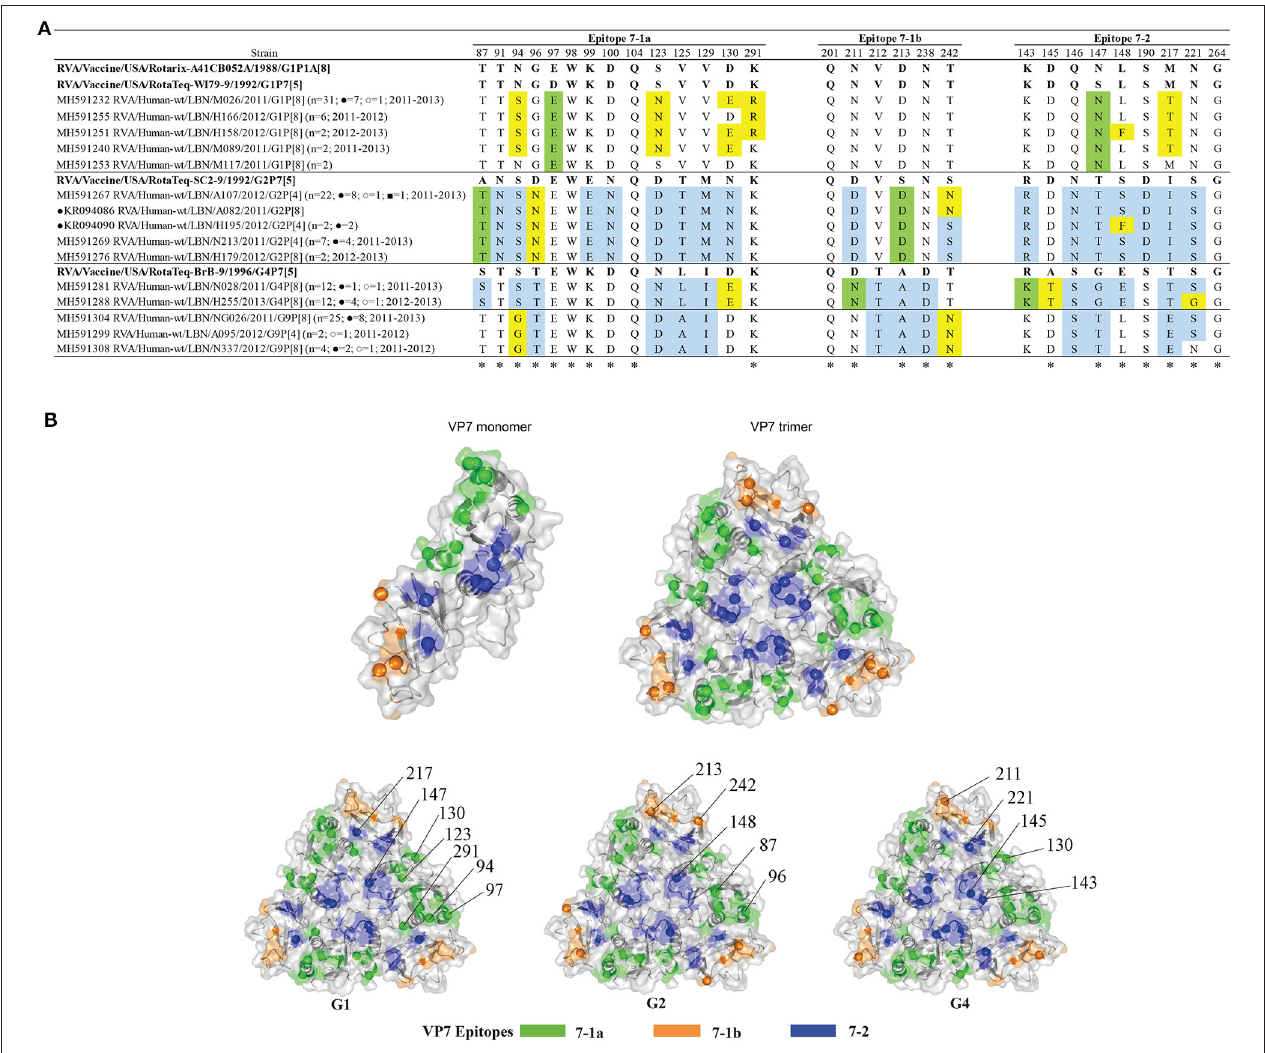
FIGURE 3 | (A) Alignment of the antigenic epitopes of VP7 of the Lebanese RVAs with those of the vaccines. Representative Lebanese strains corresponding to those in the VP7 tree are shown. Residues that are different from Rotarix ® and RotaTeq ® are highlighted in yellow, in green-color are residues that are different from the respective genotypic strain in RotaTeq ® , and in blue-color are residues that are different from Rotarix ® . Amino acid residues known to mediate escape from neutralization with mAbs ( 2, 25) are indicated by an asterisk (*). (B) Surface representation cartoon of the VP7 monomer and trimer (PDB 3FMG). Antigenic epitopes are colored in green (7-1a), orange (7-1b), and blue (7–2). Substitutions relevant to parent vaccine strains are shown in